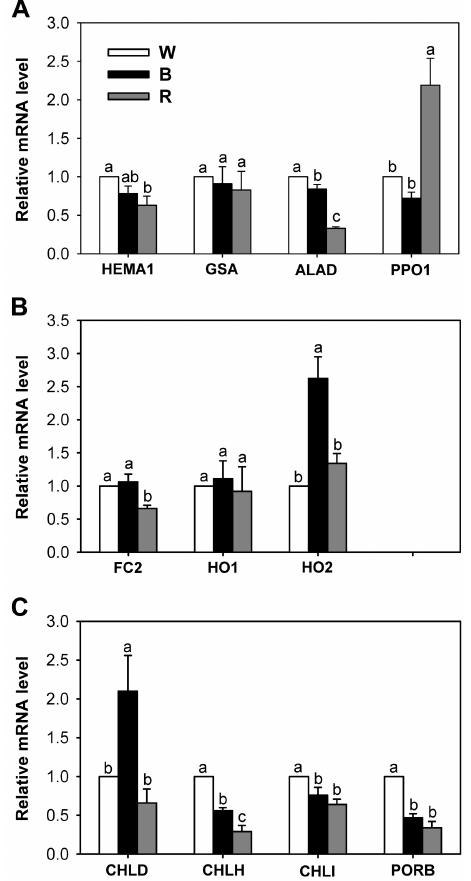
Figure 5. Effects of different wavelengths of LEDs on the expression of genes encoding the porphyrin pathway enzymes. ( A ) Common branch; ( B ) Fe-porphyrin branch; and ( C ) Mg-porphyrin branch. The plants were subjected to the same treatments as in Figure 2. Treatment notations are the same as in Figure 2. Total RNAs were purified from plants and reverse transcribed. The resultant cDNAs were used as templates for qRT-PCR using Actin as an internal control. The white LED (control) was used for normalization, with the expression level of the sample set to 1. Error bars indicate SEM from three independent experiments ( n = 3); each experiment has three biological replicates. Means denoted by the same letter did not differ significantly at p < 0.05 according to Duncan’s multiple range test.